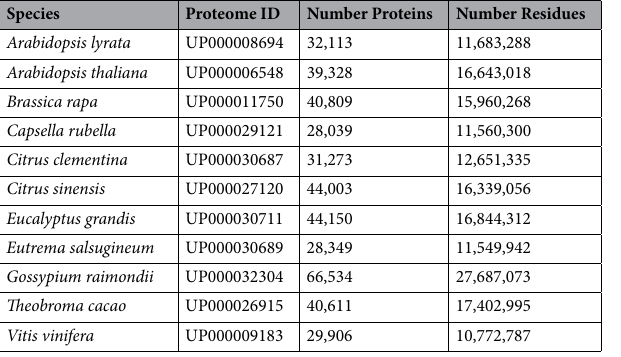
Table 3. Plant dataset used to benchmark Env-NJ and other alignment-free approaches. The FASTA files were downloaded from UniProtKB and used without further processing for establishing the phylogenetic relationship between the indicated species.